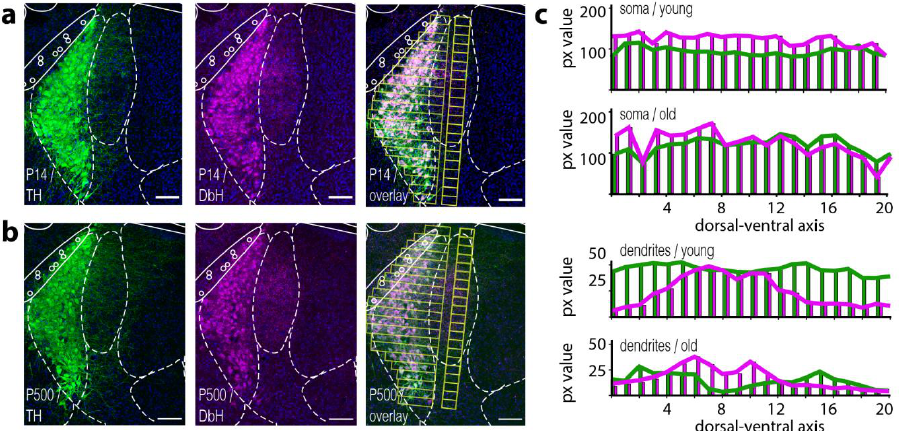
Figure 1. Tyrosine hydroxylase and dopamine-beta-hydroxylase expression largely overlap in somatic and dendritic compartments in the Locus coeruleus. ( a ) Shows immunostaining against key enzymes in the synthesis pathway of NE. White dotted lines show an overlay mask of the corresponding section from The Mouse Brain in Stereotaxic Coordinates 3rd Edition Franklin and Paxinos. ( a ) Confocal image of immunofluorescence against tyrosine hydroxylase (TH/green) from a brain stem slice of a young P14 mouse (anterior-posterior axis: − 5.40 mm). The fluorescence signal is present in the soma as well as in the dendritic arbor (here more dominantly in the medial part); we observed a similar spatial distribution for the fluorescence signal from immunostainings against the dopamine-beta-hydroxylase (magenta). ( b ) Depicted are the same immunostainings as in ( a ) on brain slices obtained from an